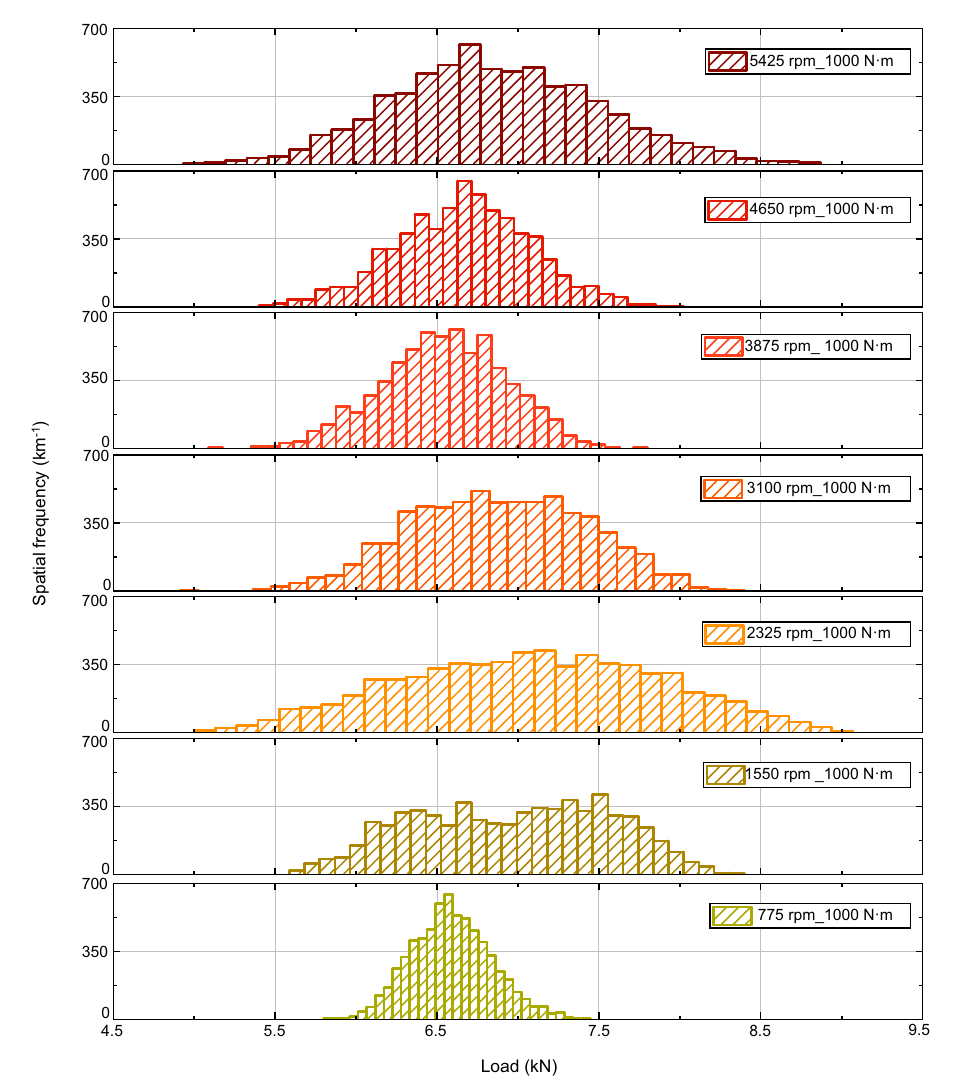
Fig. 10 Frequency distribution histograms of the measured bearing load under different speed conditions of gear meshing (input torque: 1000 N·m)